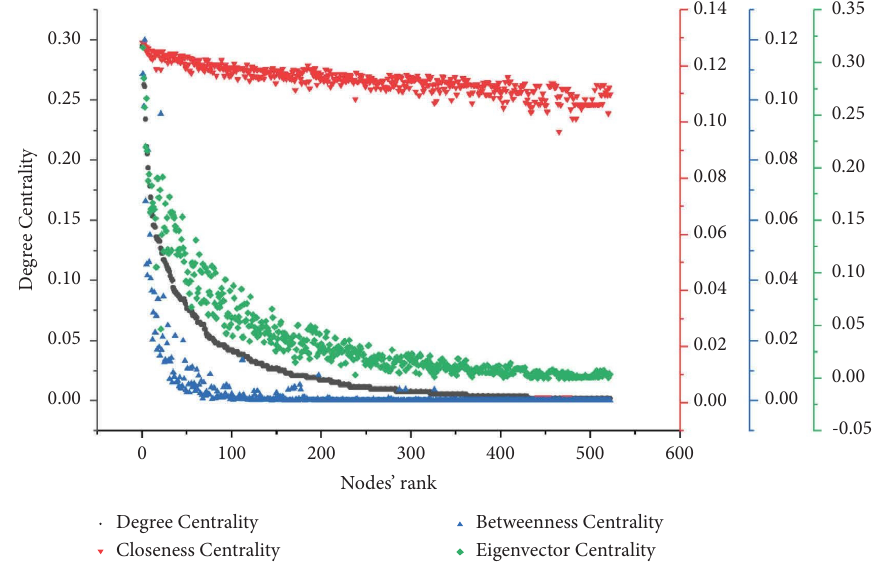
Figure 3: Position-scale distribution diagram of centrality indicators. Table 1: Te “Belt and Road” aviation community networks’ scale and geographical